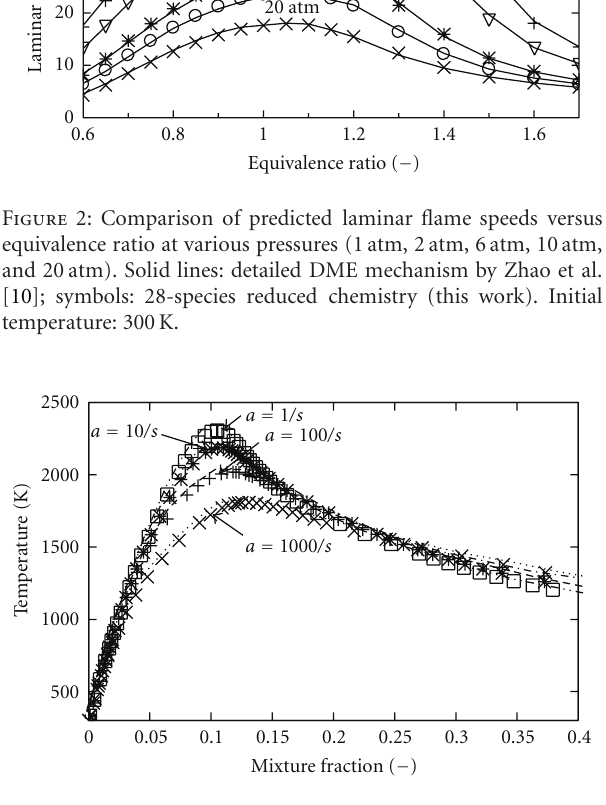
Figure 3: Comparison of computed temperatures versus mixture fraction for a Tsuji burner at strain rates a = 1 /s , 10 /s , 100 /s , 1000 /s . Lines: detailed DME chemistry by Zhao et al. [10]; symbols: 28- species reduced chemistry (this work).